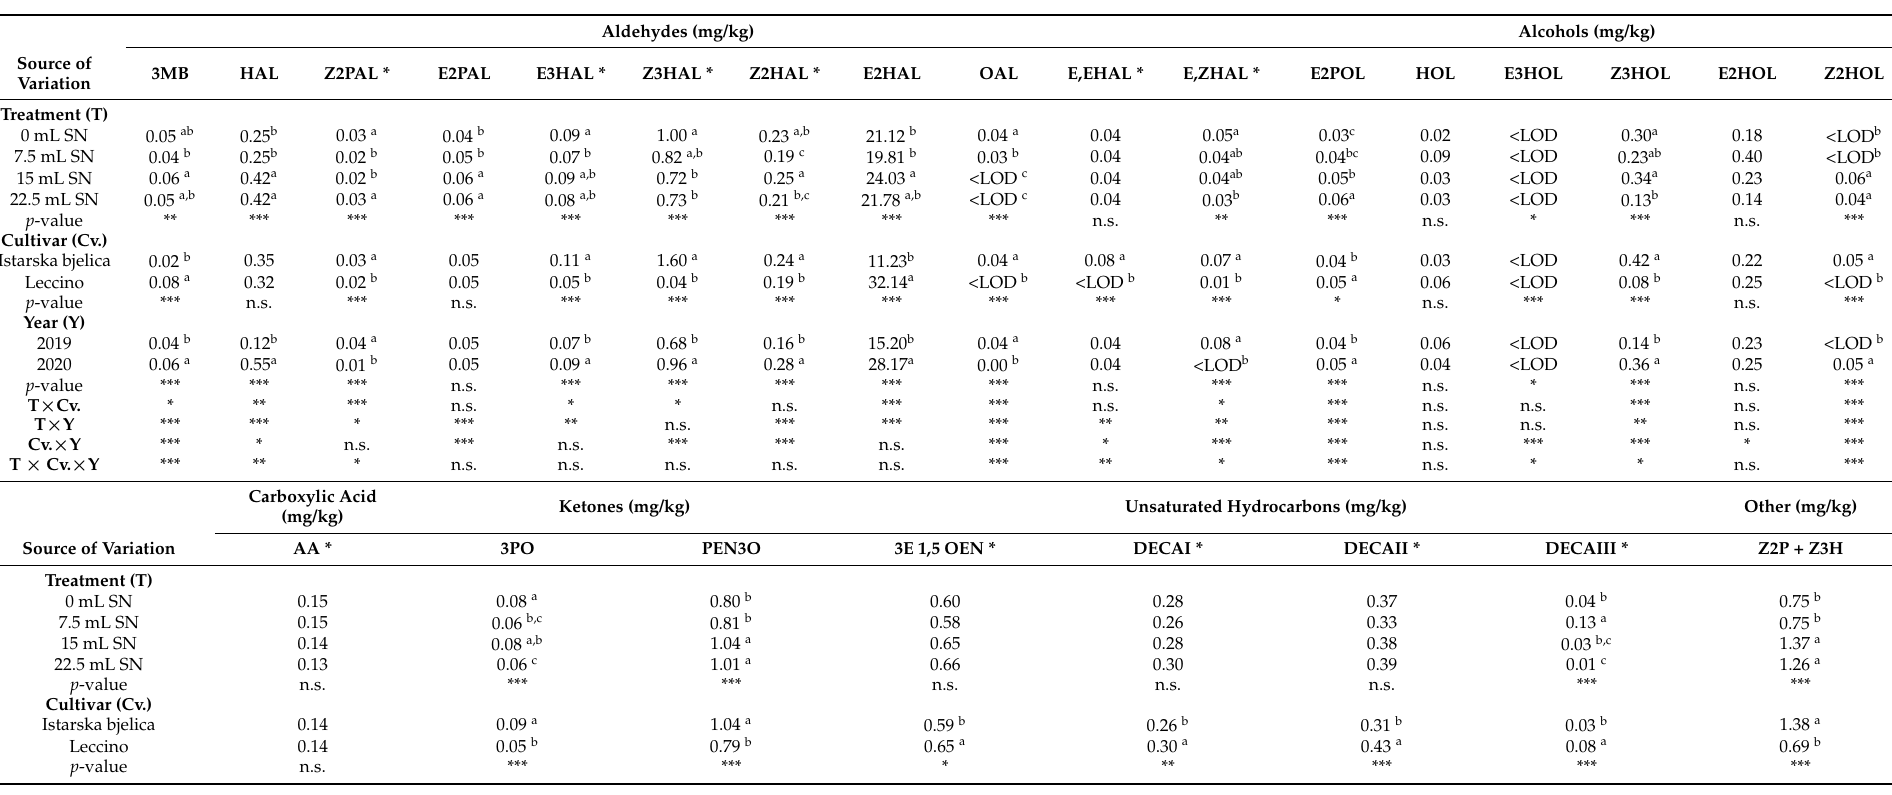
Table 2. The effect of treatment (T) (0, 7.5, 15, and 22.5 mL of the applied SN foliar fertilizer per 1 L of water), cultivar (cv.) (Istarska bjelica, Leccino), and collection year (Y) (2019, 2020) on the concentrations of volatile compounds in olive